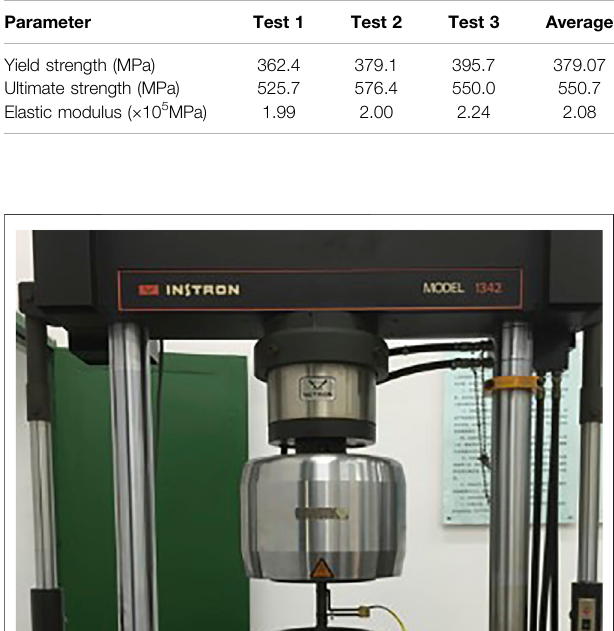
TABLE 4 | Testing parameters of steel